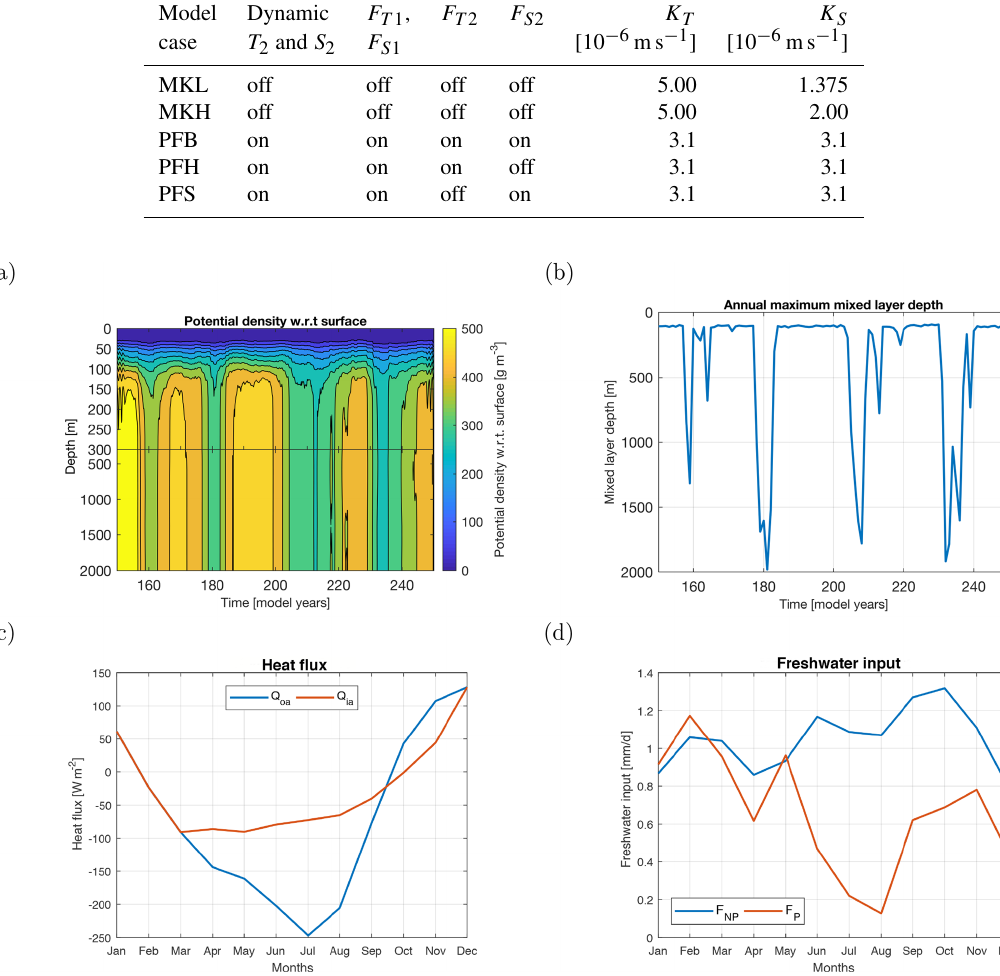
Figure 3. (a) Potential density over depth for model years 150–250 from the CESM simulation; the time series are smoothed through a 5-year running mean. (b) The annual maximum mixed layer depth for model years 150–250 from the CESM simulation. (c) The heat fluxes (in Wm − 2 ; see also Table 3) are determined from the CESM simulation. These values are interpolated linearly in the model as displayed in this figure. (d) The freshwater input (in mmd − 1 ; see also Table 3) is determined from the CESM simulation. All quantities are spatially averaged over the polynya region (2–11 ◦ E × 66.5–63.5 ◦ S, Fig.